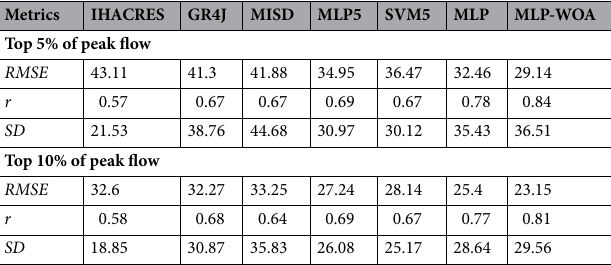
Table 12. RMSE , r , and SD of the top 5% and 10% of measured peak flow and simulated peak flow.